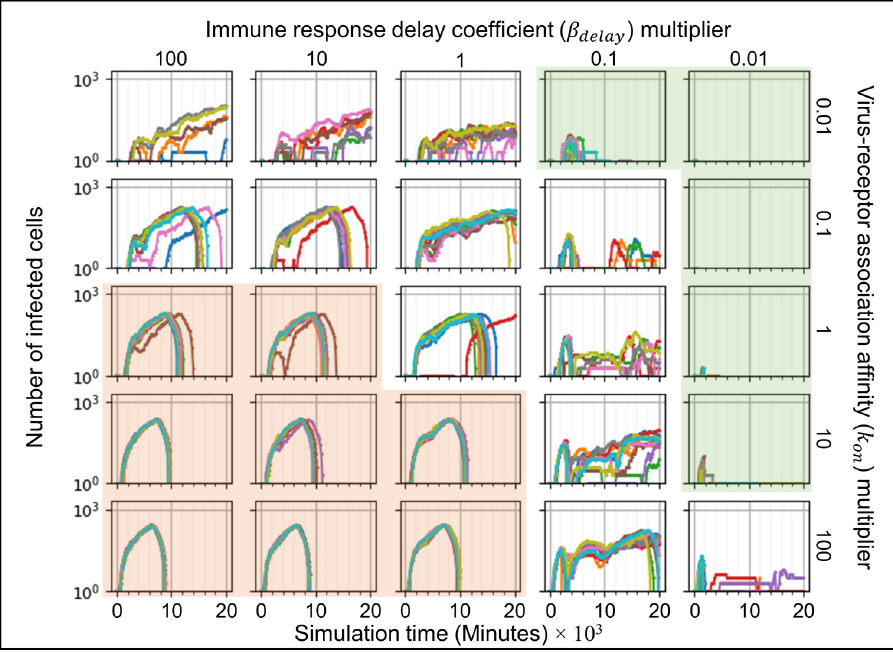
Fig 6. Sensitivity analysis of the number of infected epithelial cells vs time for variations in virus-receptor association affinity k and immune response delay coefficient β , showing regions with distinct infection on delay dynamics. Same parameter sweep as Fig 5. The number of infected epithelial cells for each simulation replica for each parameter set, plotted on a logarithmic scale, vs time displayed in minutes. See Fig 4 for the definitions of the classes of infection dynamics.